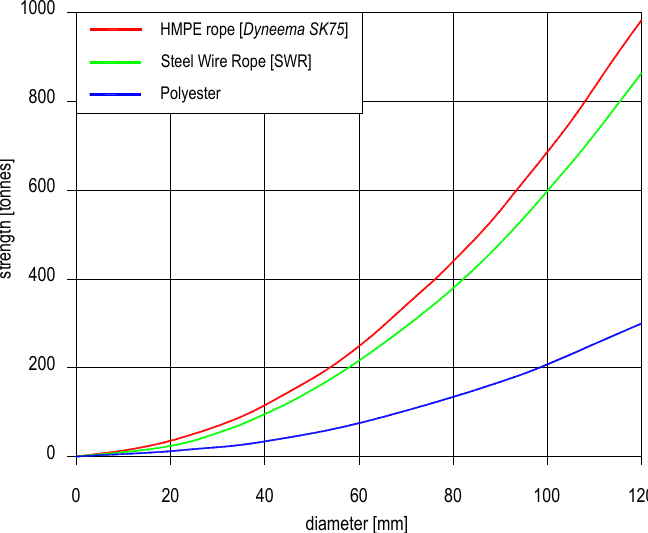
Figure 12. Rope properties, strength versus diameter of different lines as per Samson Rope manufacturer. Drawing: Authors.